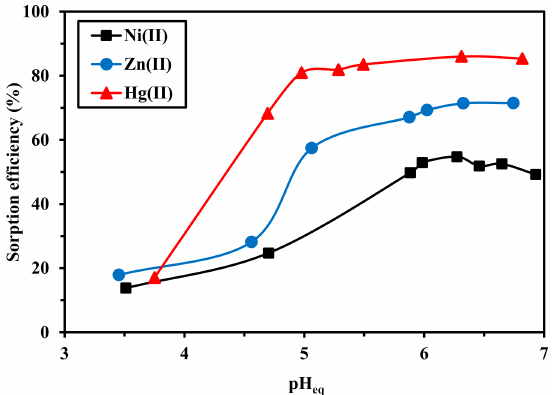
Figure 4. Effect of pH on the sorption efficiency for Ni(II), Zn(II), and Hg(II) using G@MChs (C 0 : 0.3 mmol L − 1 ; sorbent dose, SD: 1 g L − 1 ; T: 21 ± 1 ◦ C; time: 480 min; agitation speed: 150